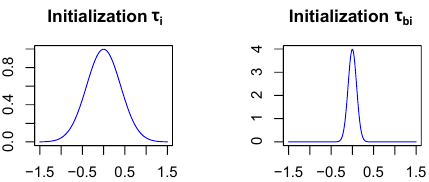
Figure 5. Visualization of the initialization of τ i and τ bi . Network weights can differ at most by the size of their expectation value from their expectation value.